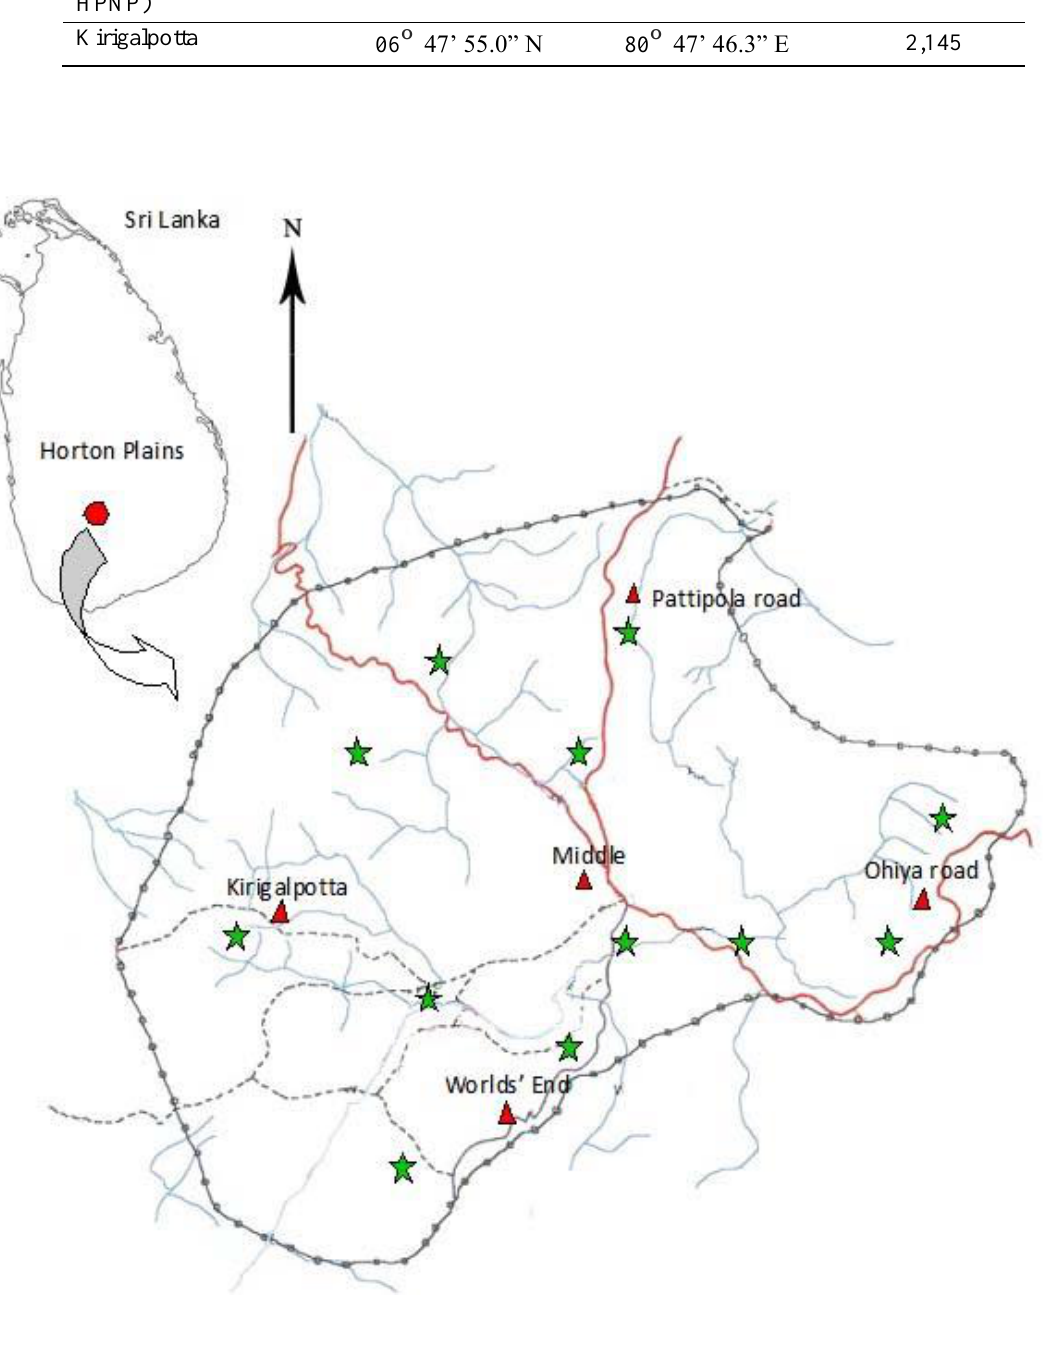
Figure 1: Map of Horton Plains National Park showing air sampling sites (red triangles) and lichen sampling sites (green